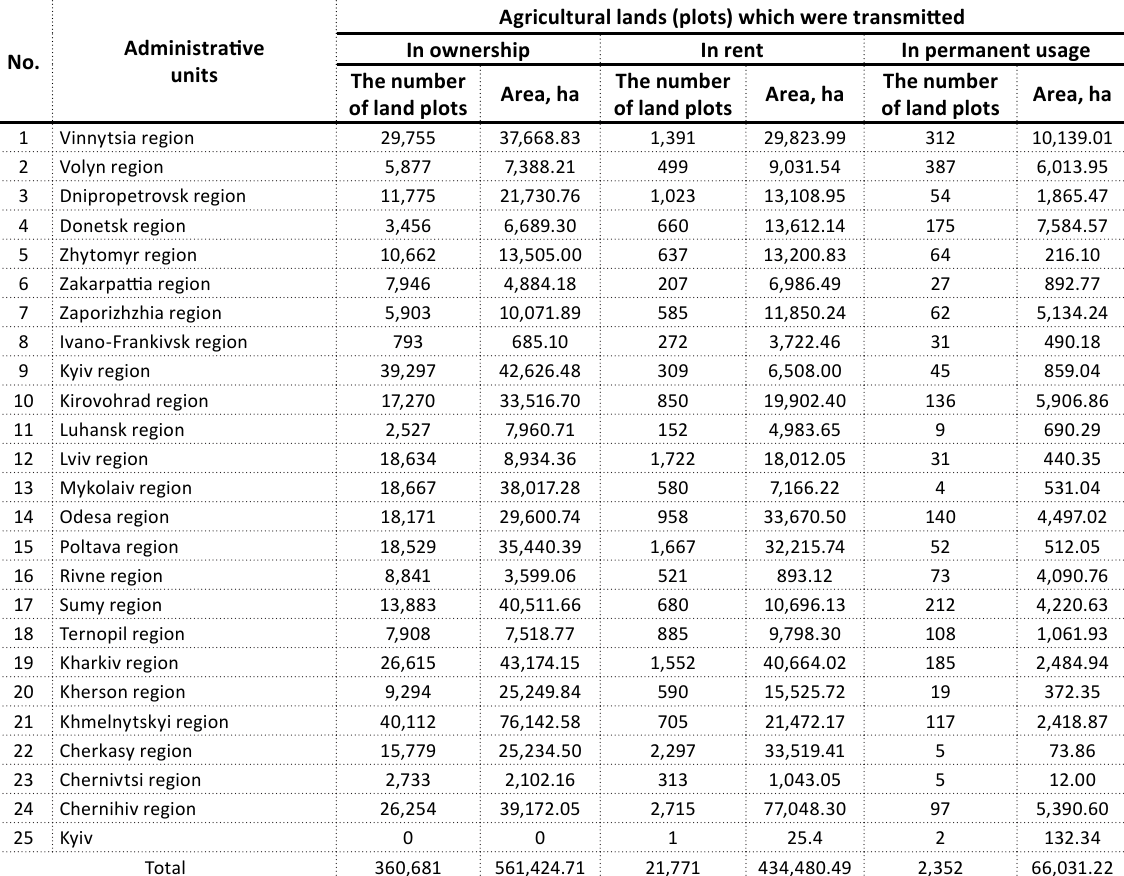
Table 1. Information related to realization of authority by the local communities of State Geo Cadastre according to disposal of agricultural lands, which belongs to public ownership (as of January 1,